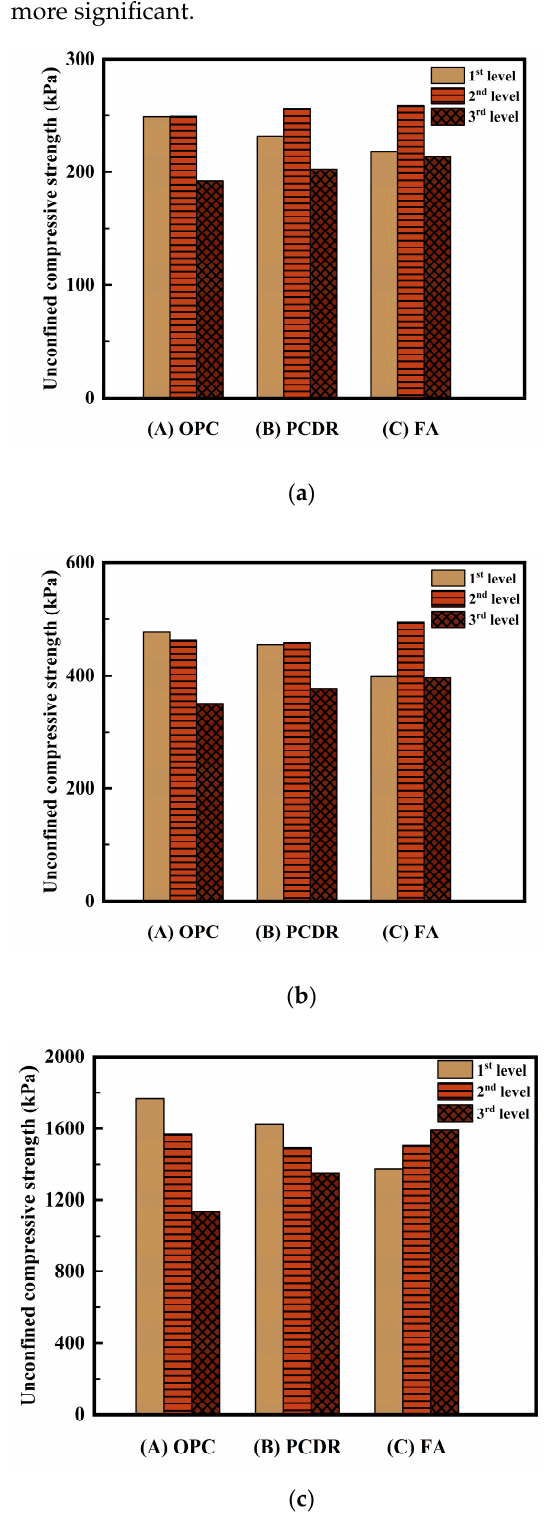
Figure 3. Extremely bad trend chart of orthogonal test results when the initial water content of mud is 50%. ( a ) 3 days curing age. ( b ) 7 days curing age. ( c ) 28 days curing